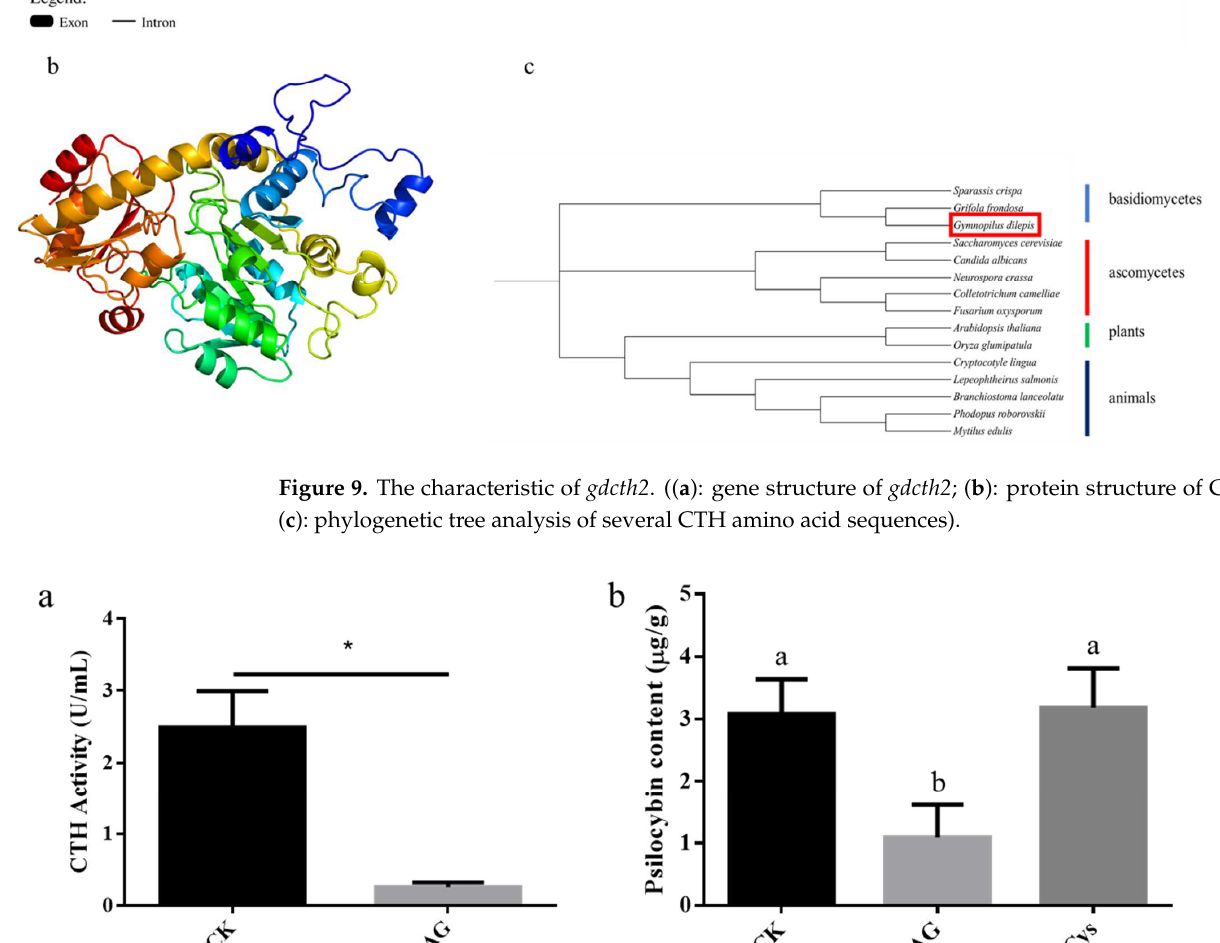
Figure 9. The characteristic of gdcth2 . (( a ): gene structure of gdcth2 ; ( b ): protein structure of CTH; ( c ): phylogenetic tree analysis of several CTH amino acid sequences).